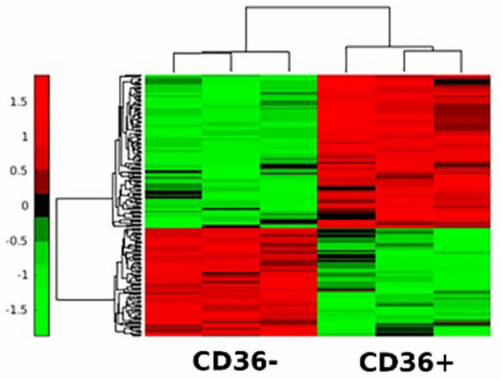
Figure 7. Differential profiling between the CM of CD36 + and CD36 − FBs identifies 187 proteins with p -values of less than